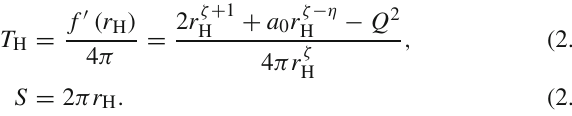
(a) without island (b) with